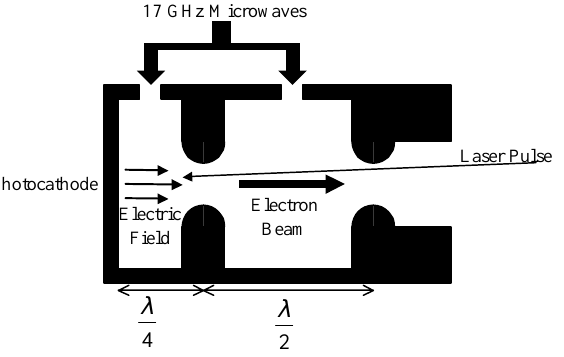
FIG. 1. Schematic of the RF